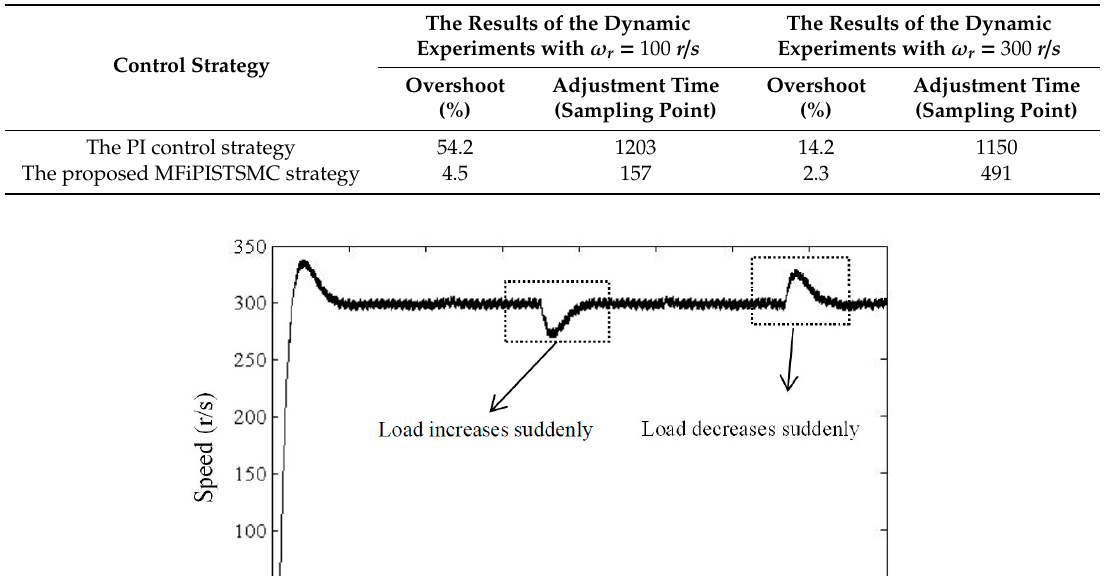
Table 6. The comparative results of the dynamic experiments.